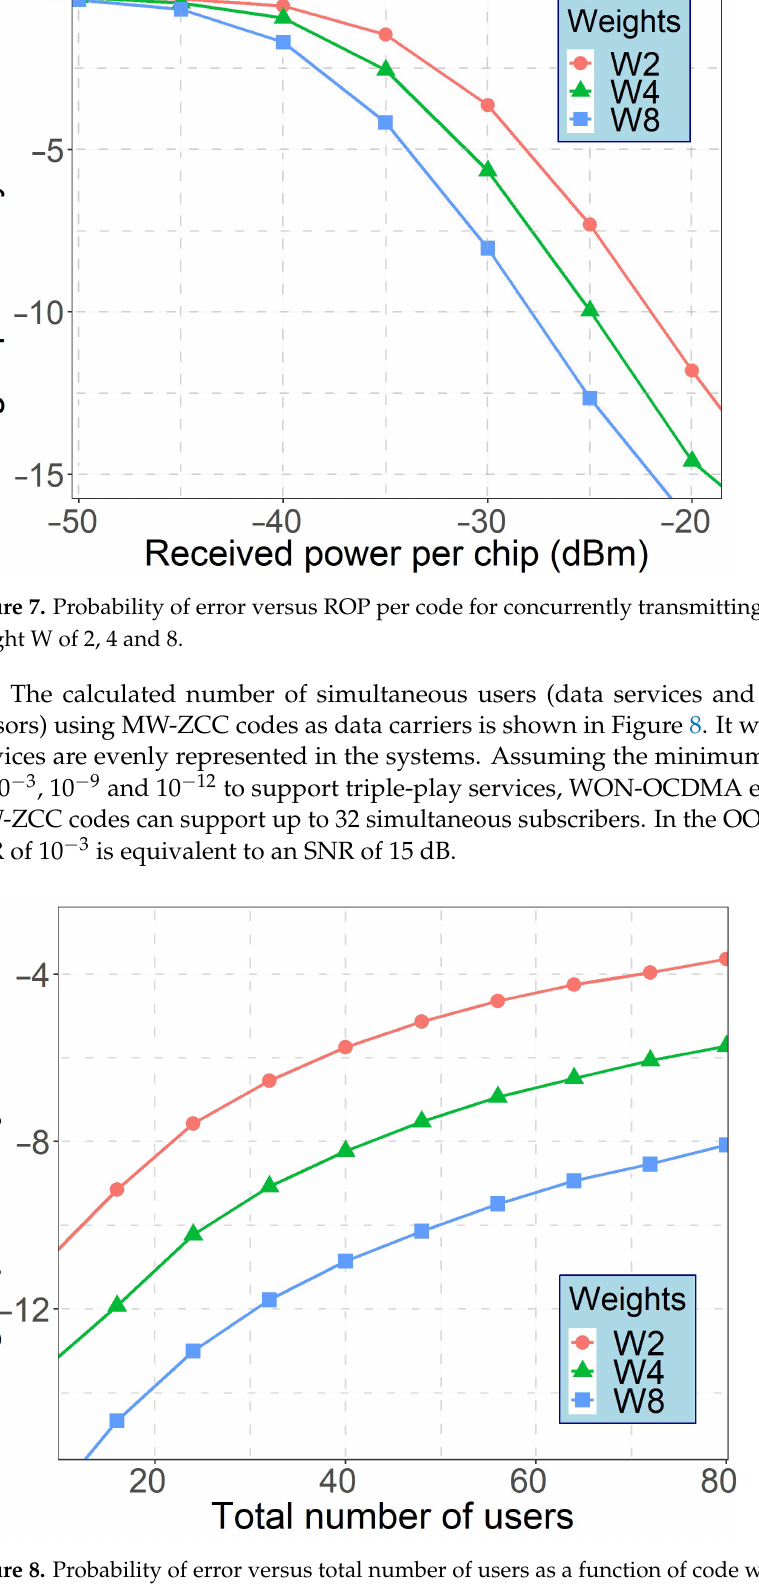
Figure 8. Probability of error versus total number of users as a function of code weight W of 2, 4, 8. The performance degradation due to increased transmission distance in the atmo- sphere under moderate turbulence with 32 simultaneous users’ (including